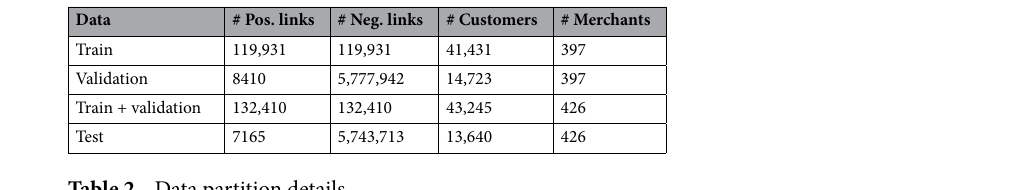
Table 2. Data partition